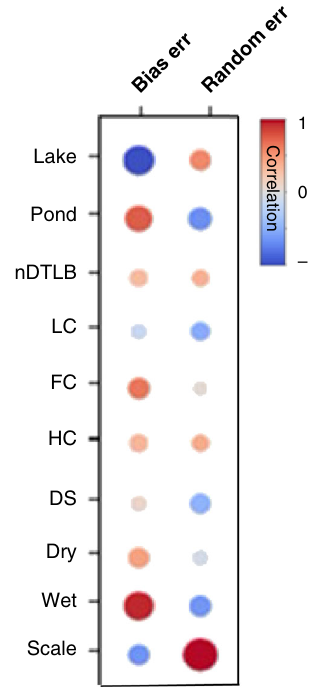
Fig. 7 Pearson ’ s correlations of uncertainty metrics (bias and random error) and spatial attributes. The larger the bubble the greater the p value. Landform categories dry and wet include spatial data from “ DS + HC ” and “ FC + LC + nDTLB + Pond ” , respectively. See Supplementary Fig. 3 for correlation bubble plots of all